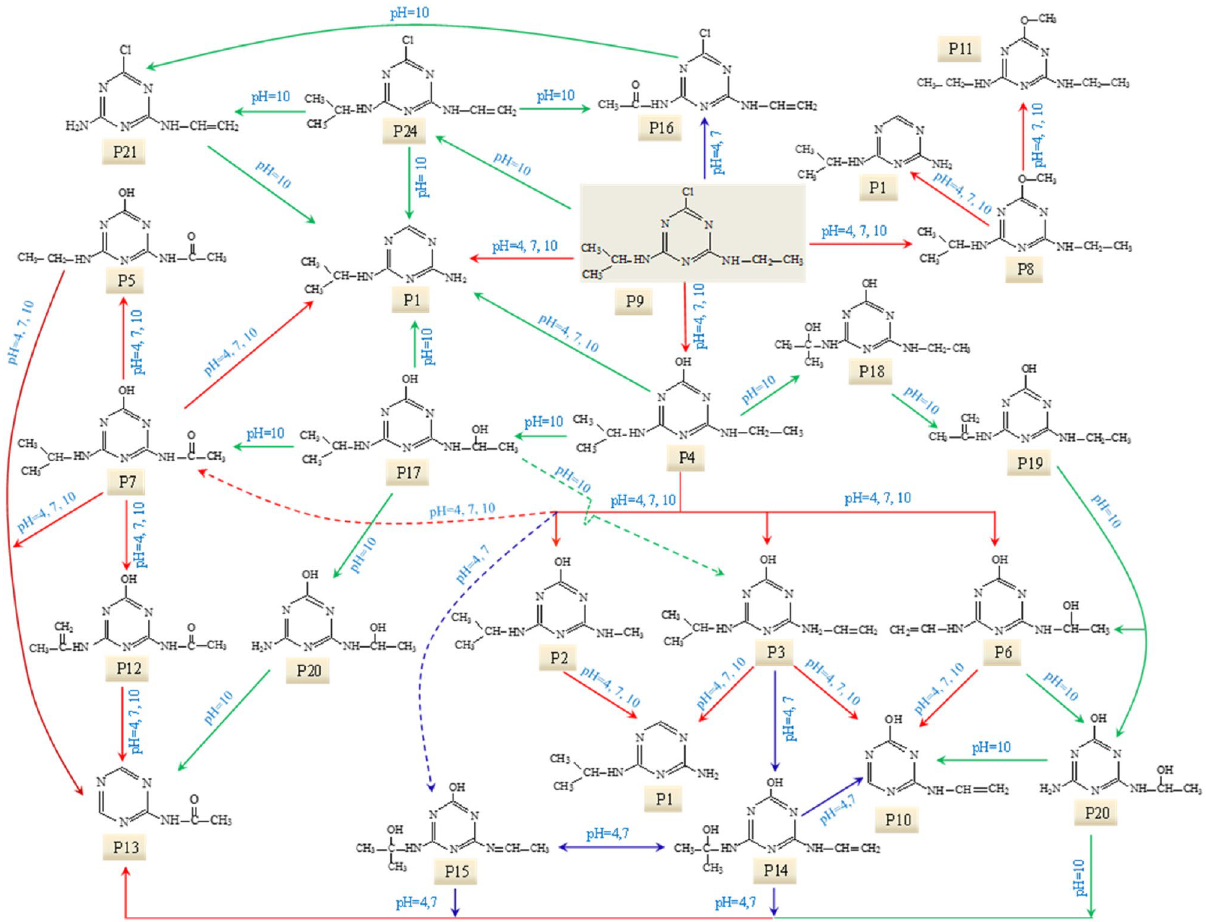
Figure 5. The proposed degradation pathway of ATZ in UV/H 2 O 2